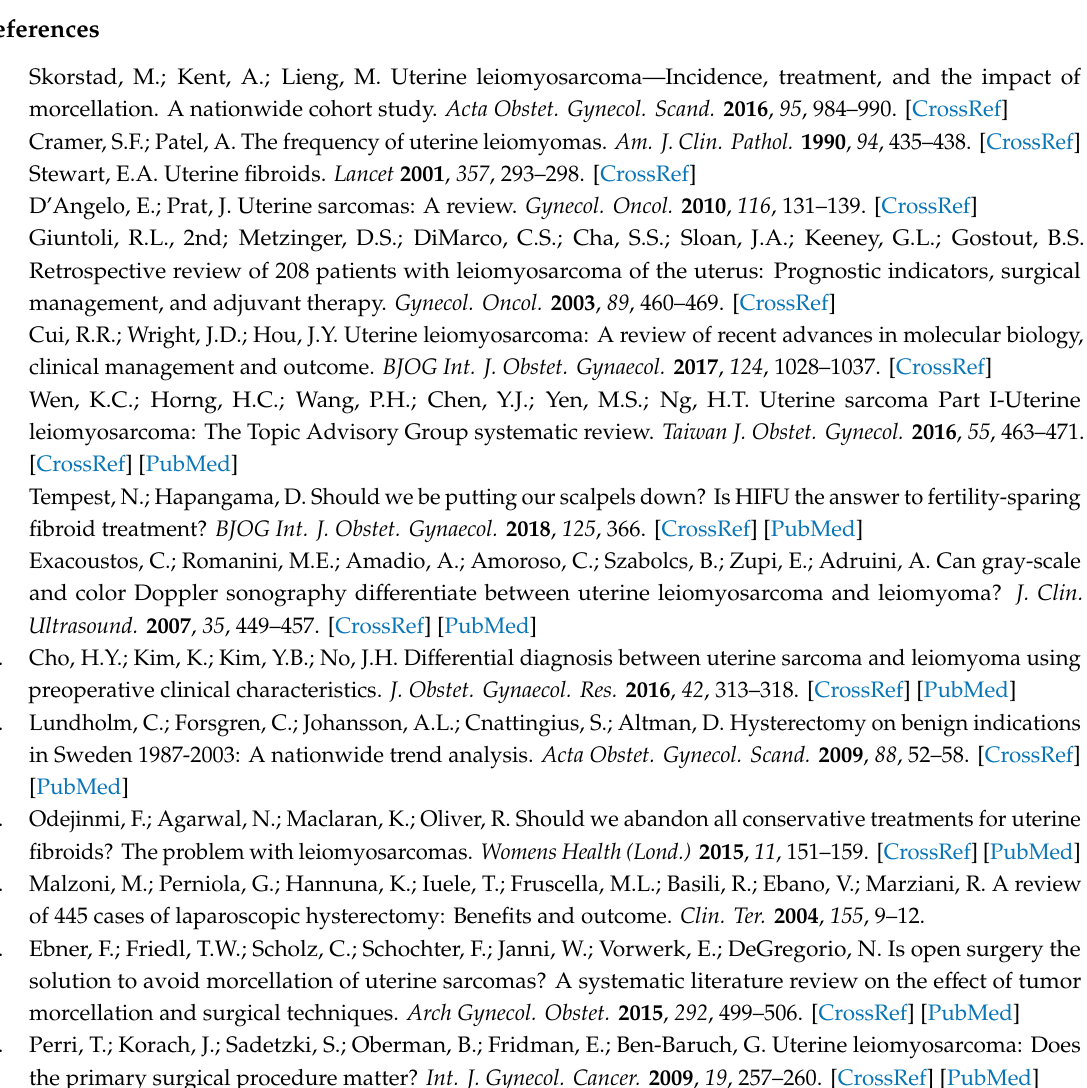
Supplementary Table S2: Normal reference ranges for blood